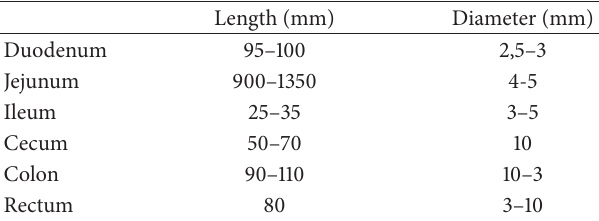
Table 3: Length and diameters of parts of rat intestinal tract